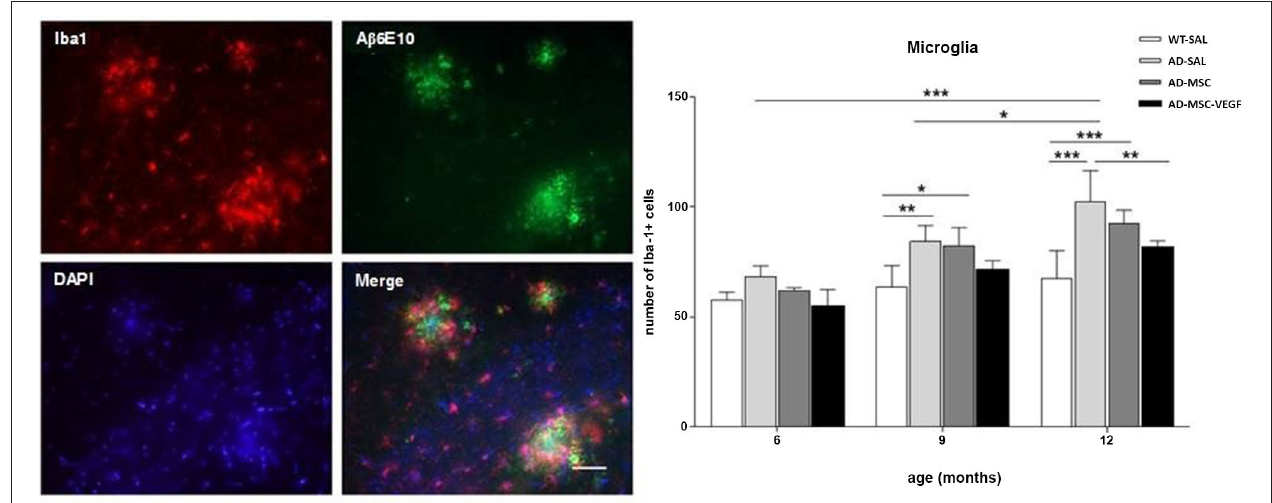
(scale bar 200 µ m). The number of Iba-1 + cells counted in the WT, AD-SAL, AD-MSC and MSC-VEGF mice at 6, 9 and 12 months (two-way ANOVA followed by Tukey’s multiple comparisons test, mean ± standard error; * P < 0.05; ** P < 0.01; *** P < 0.001, n = 5 per